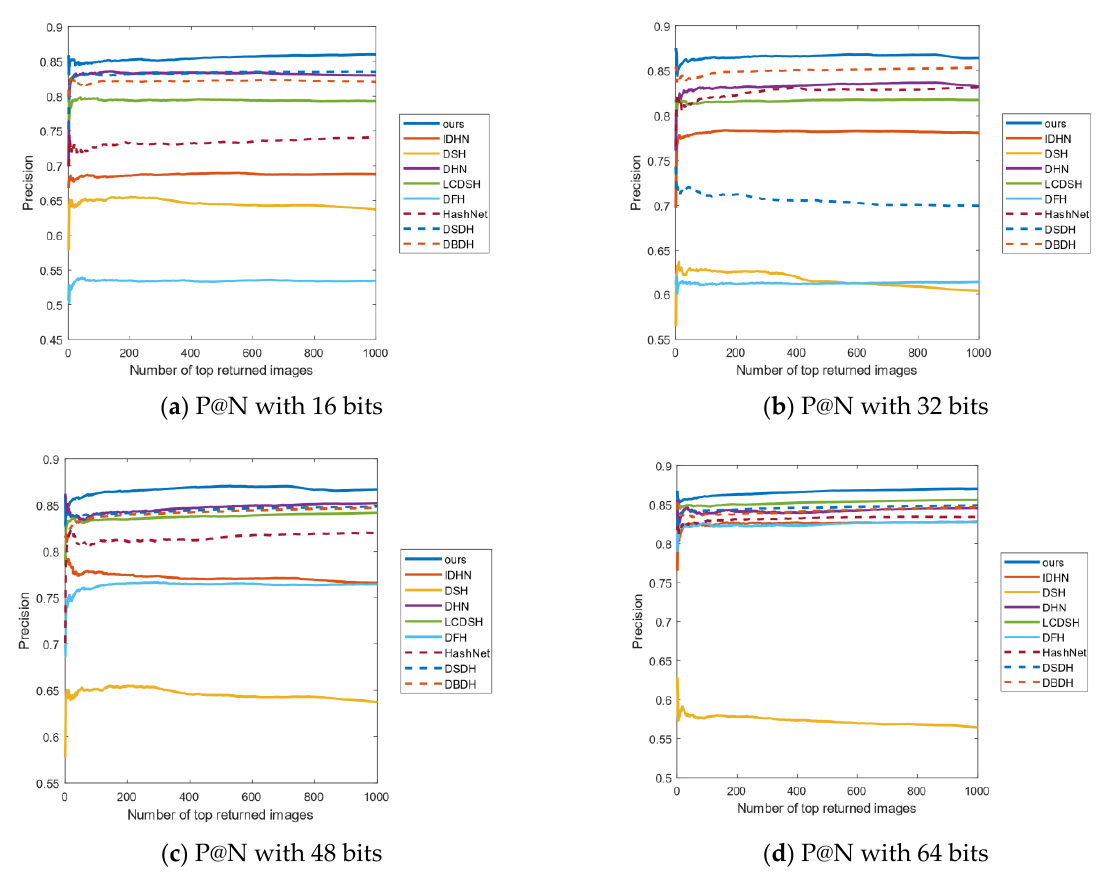
Figure 7. ( a – d ) represent the P@N curves on CIFAR-10 of all algorithms when the length of the hash code is 16, 32, 48 and 64 bits, respectively.